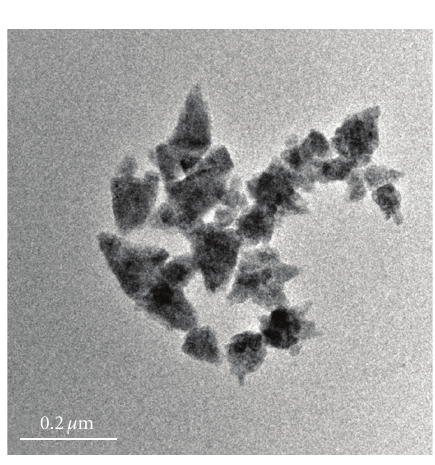
Figure 2: TEM image of ZnO NPs.